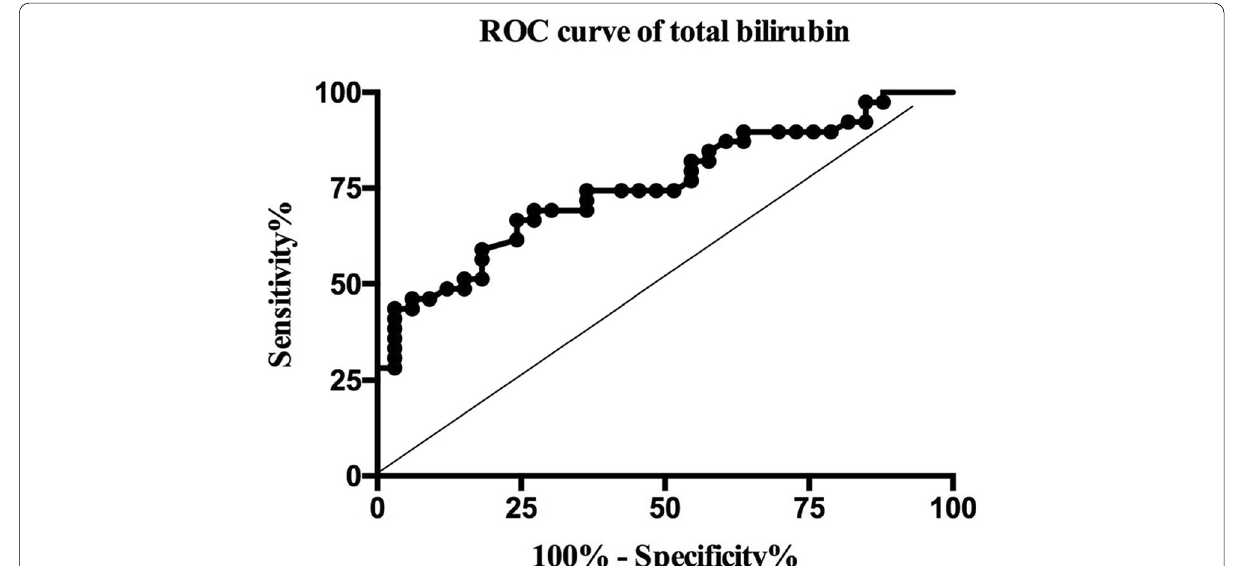
Fig. 2 The ROC curve of total bilirubin to predict PJI. AUC 0.755 (95%CI: 0.645–0.866, P < 0.001), Cutoff = Specificity 75.76%, PPV 76.47%, NPV 65.79%, OR 6.25 (95%CI: 2.21—17.65) = = = =